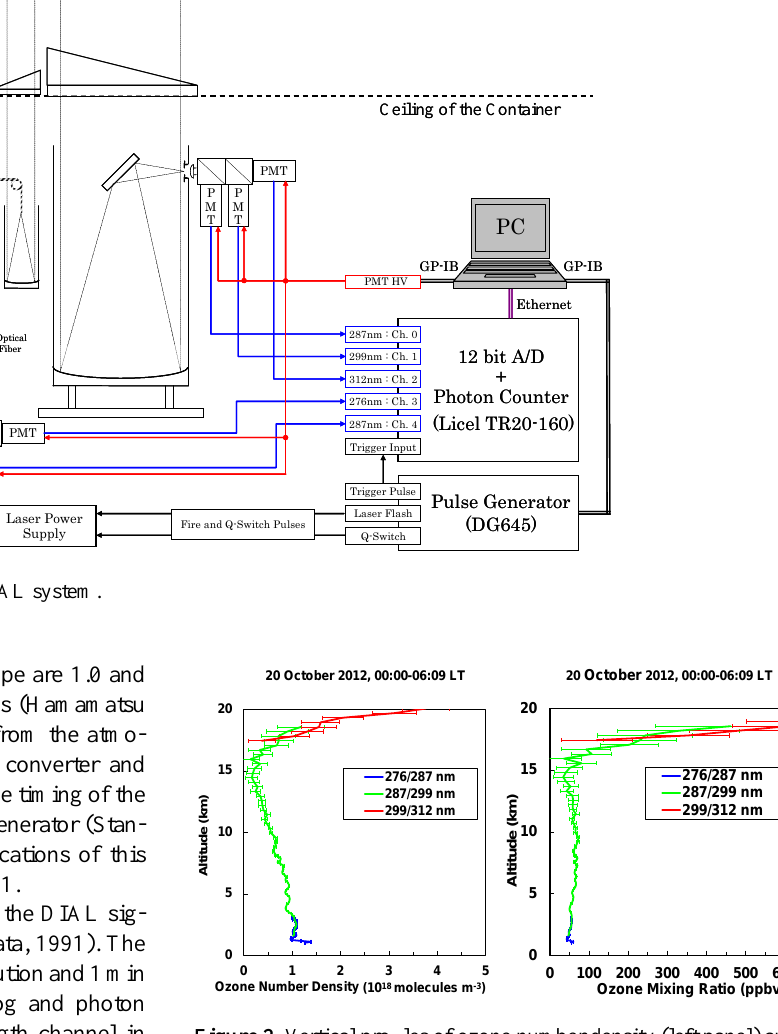
was also calculated from the molecular density, including water